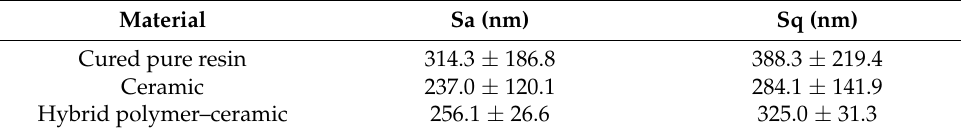
Table 2. The surface roughness of different